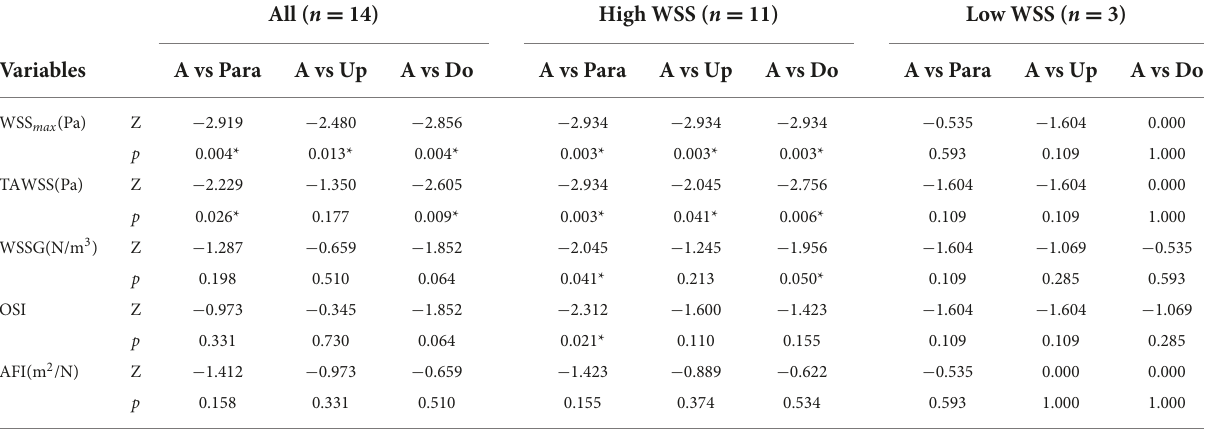
TABLE 3 Hemodynamic characteristics in aneurysm forming and para-aneurysm area among different groups. All ( n = 14) High WSS ( n =